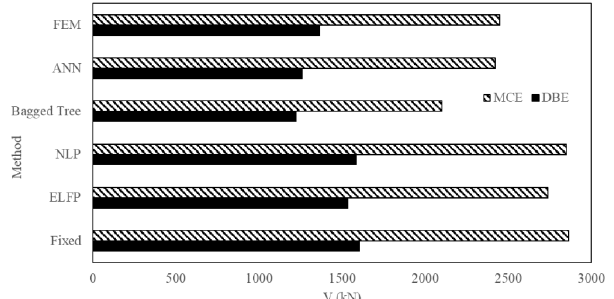
Figure 20. Comparison of base shear obtained from different techniques.